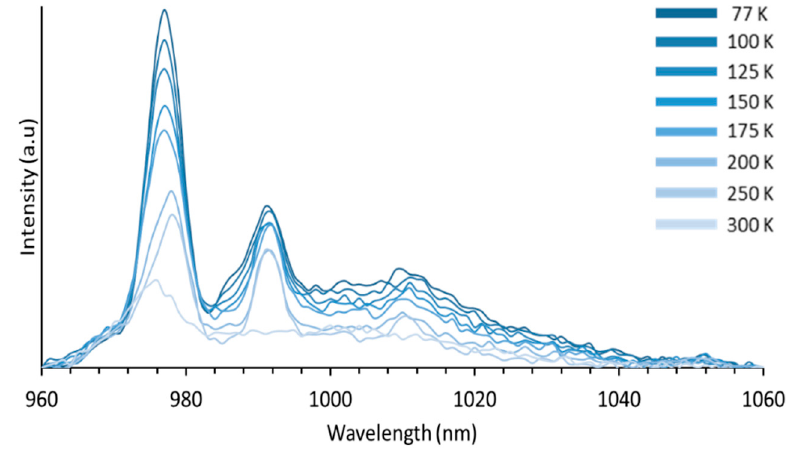
Table 1. Ytterbium lifetime in the range of 77–300 K (YbL = 5.3 × 10 − 5 , D 2 O with 12% glycerol).